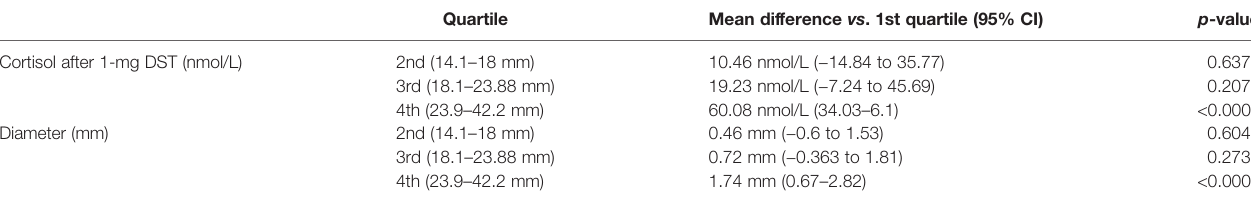
TABLE 5 | Mean differences according to the quartile of diameter.